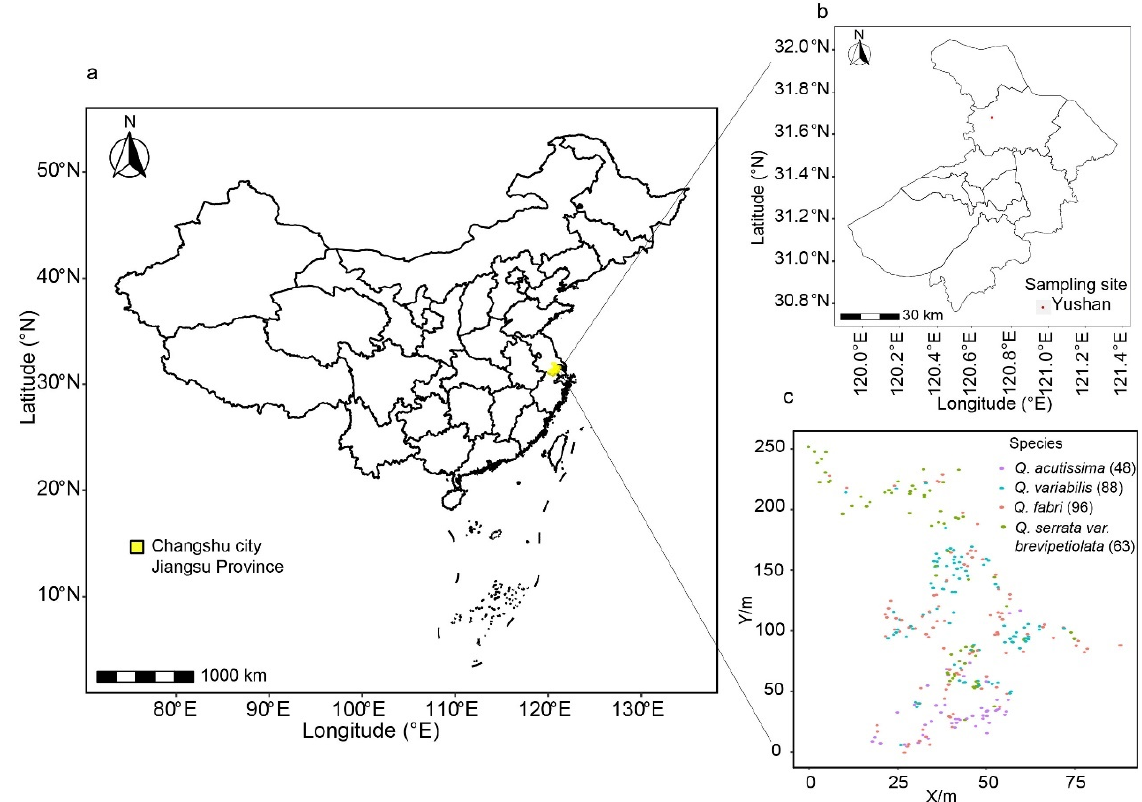
Figure 1. Sampling sites’ geographical locations and distribution of sampled trees. ( a ): sampling site in Jiangsu Province, China; ( b ): sampling site in Yushan, Changsu City; ( c ): samples numbers and GPS information.